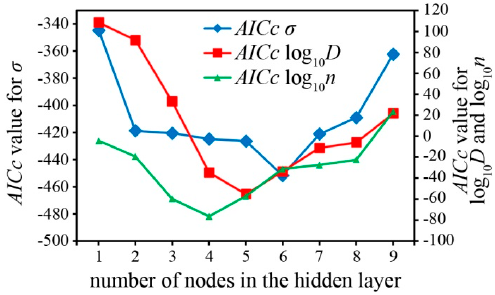
Figure 11. AICc for all the response outputs.